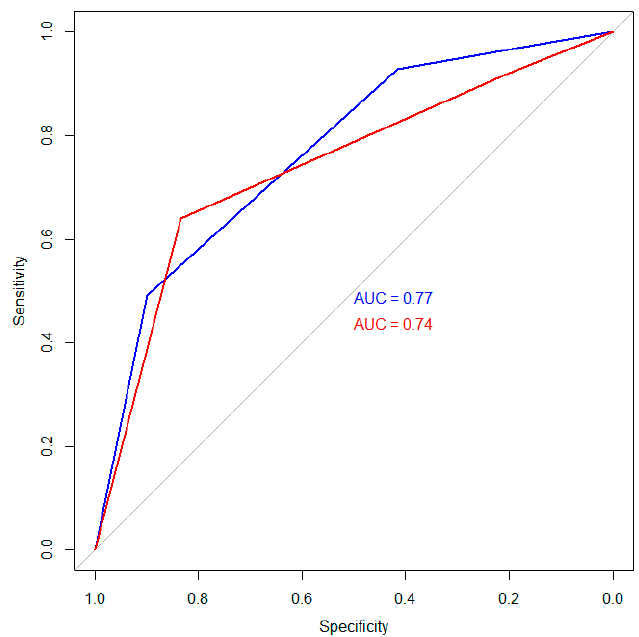
Figure 7. Receiver operating characteristic curves for the training (blue) and validation (red) sets using the Fudan score.